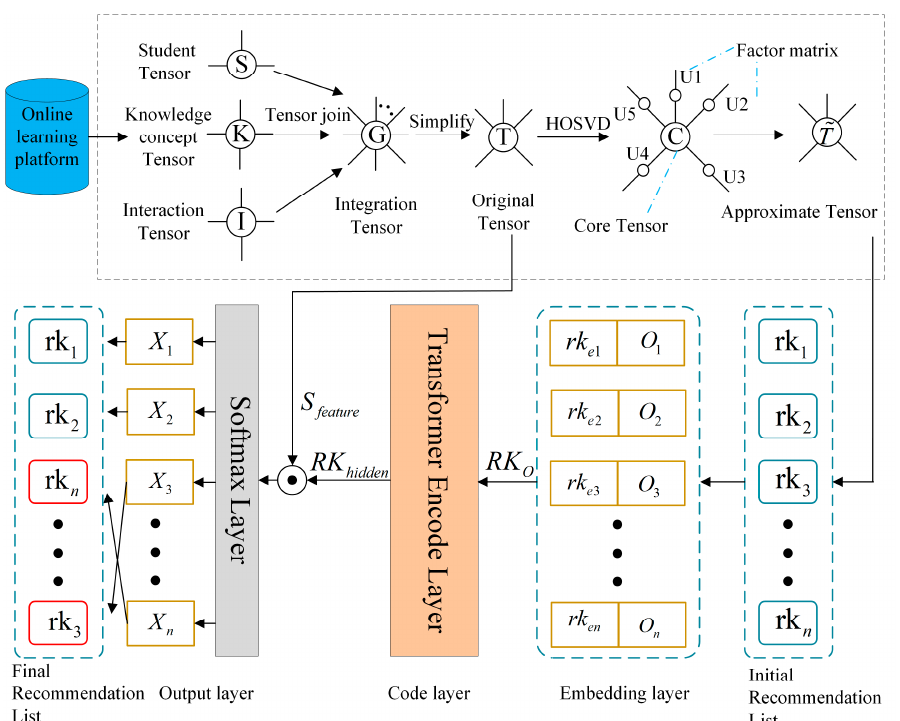
Figure 4. The overall architecture of the TTRKRec model .